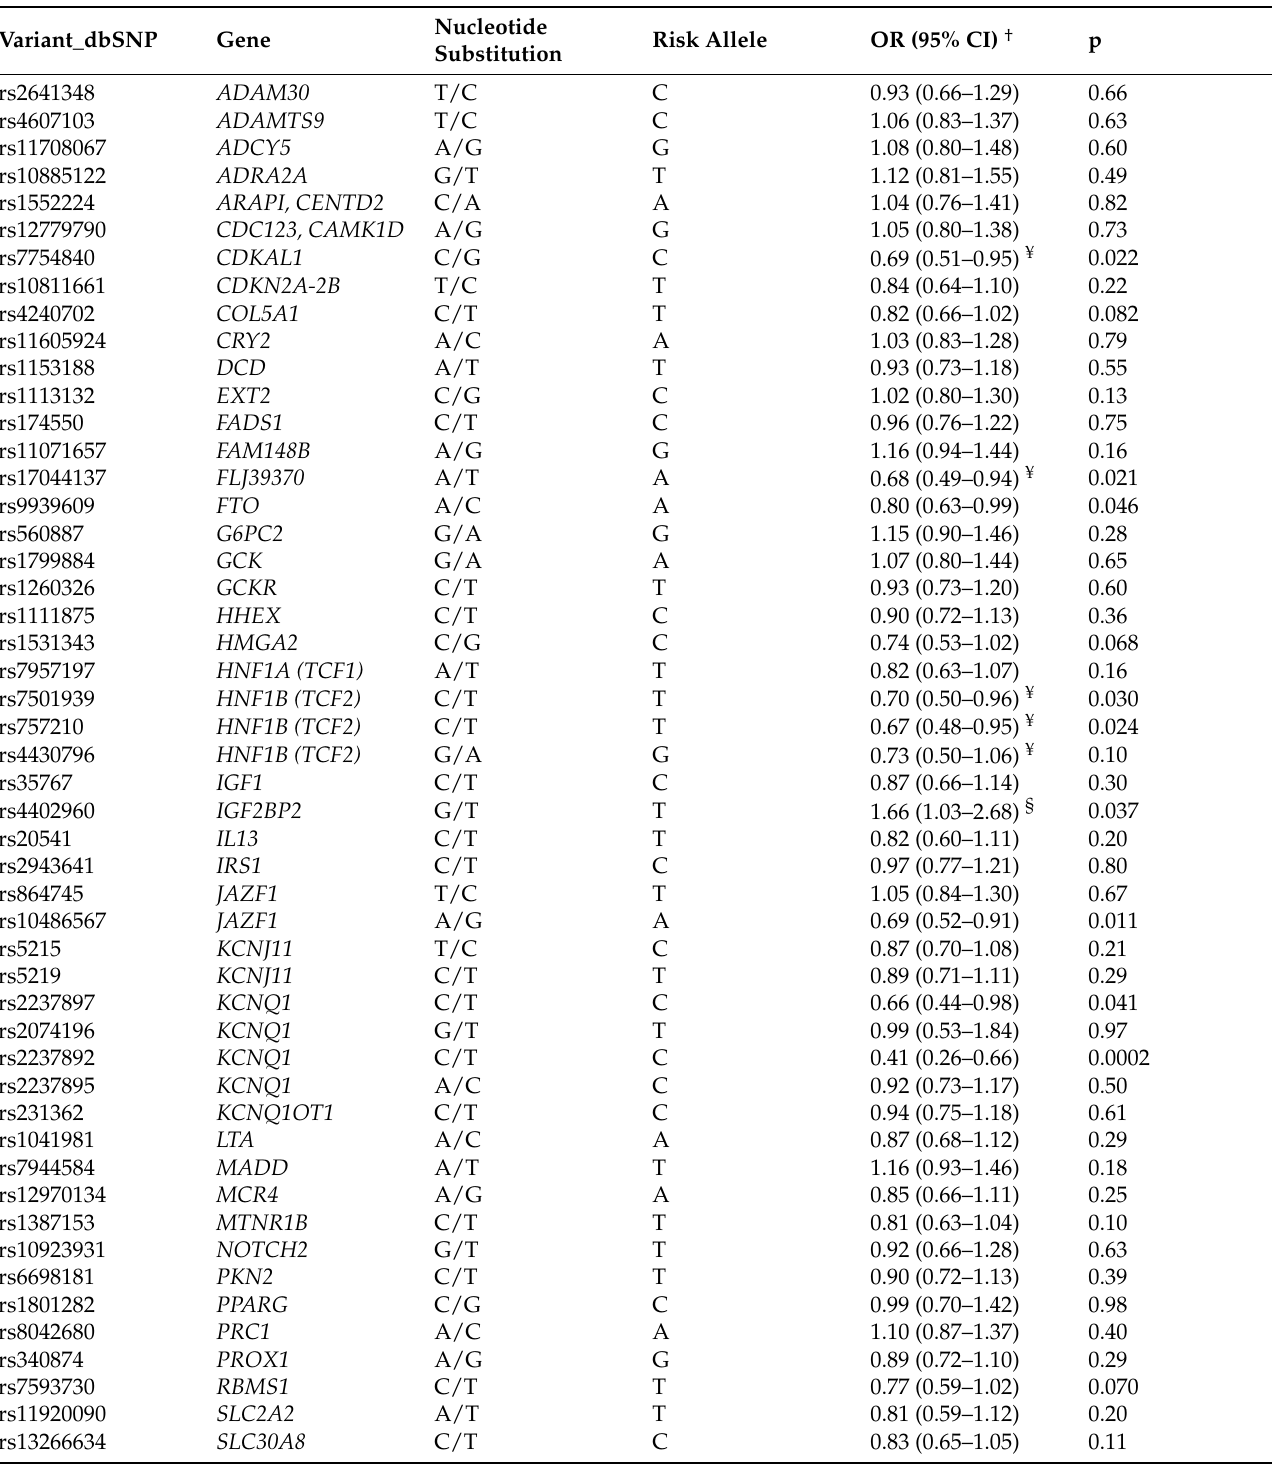
Table 3. Association of T2D-related variants and risk of developing PCa in the discovery